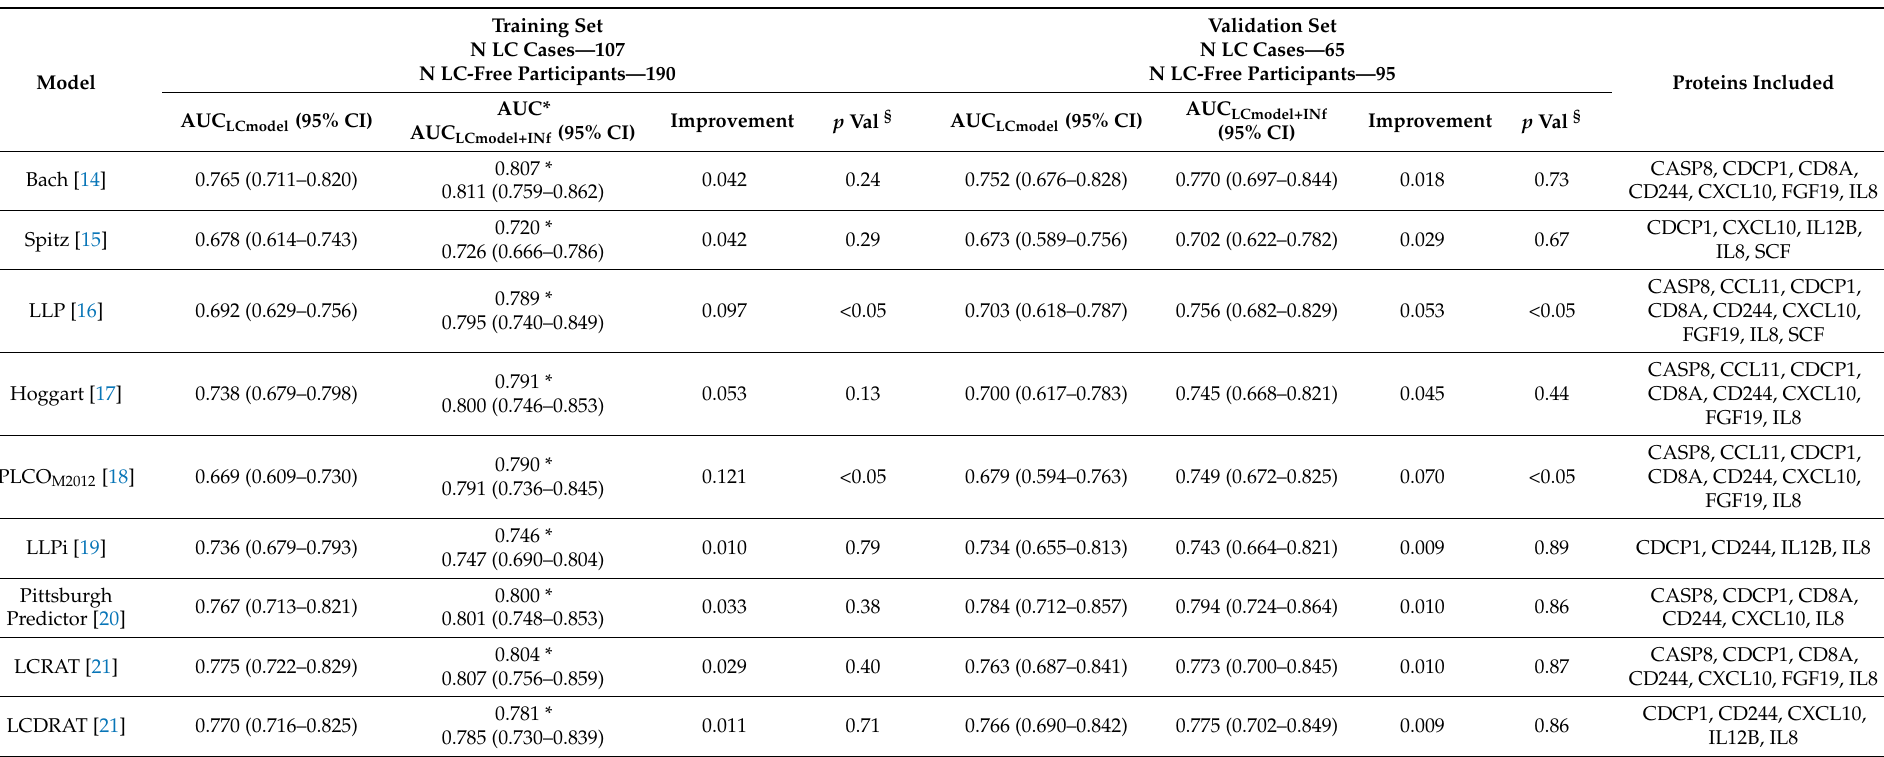
Table 3. Performances of different risk scores or models for predicting LC incidence during 17 years of follow-up in a case cohort design among ever smoking participants of the